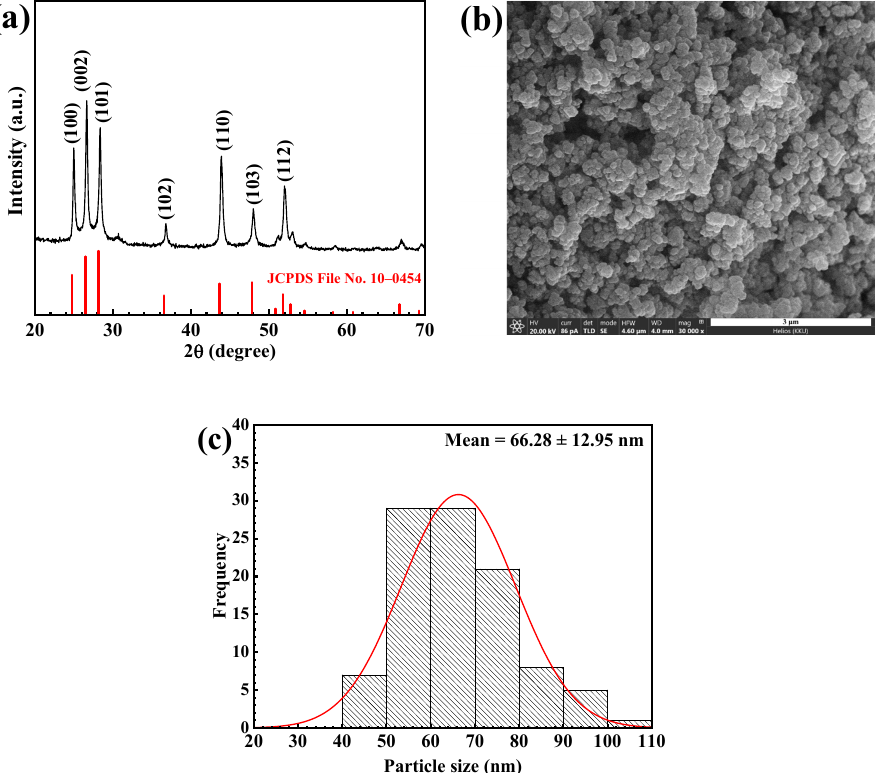
Figure 1. XRD pattern ( a ), FE—SEM micrograph ( b ), and size distribution ( c ) of the CdS nanoparticles.